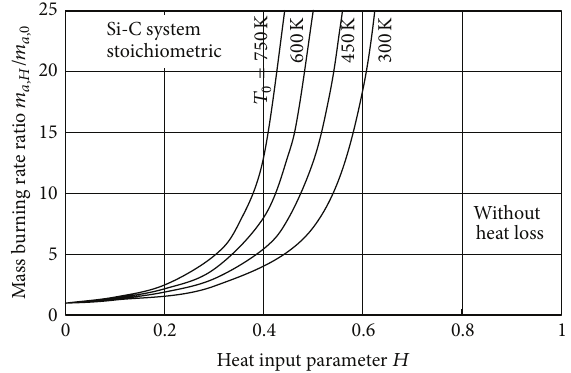
Figure 2: Normalized mass burning rate 𝑚 𝑎,𝐻 /𝑚 𝑎,0 for the stoichio- metricSi-Csystemasafunctionoftheheat-inputparameter 𝐻 ,with the initial temperature 𝑇 0 taken as a parameter when there exists no heat loss in the SHS flame propagation.